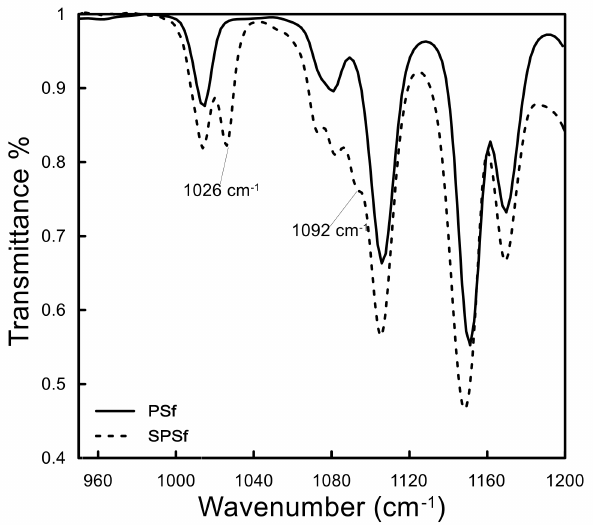
Figure 4. FTIR pattern of PSf and